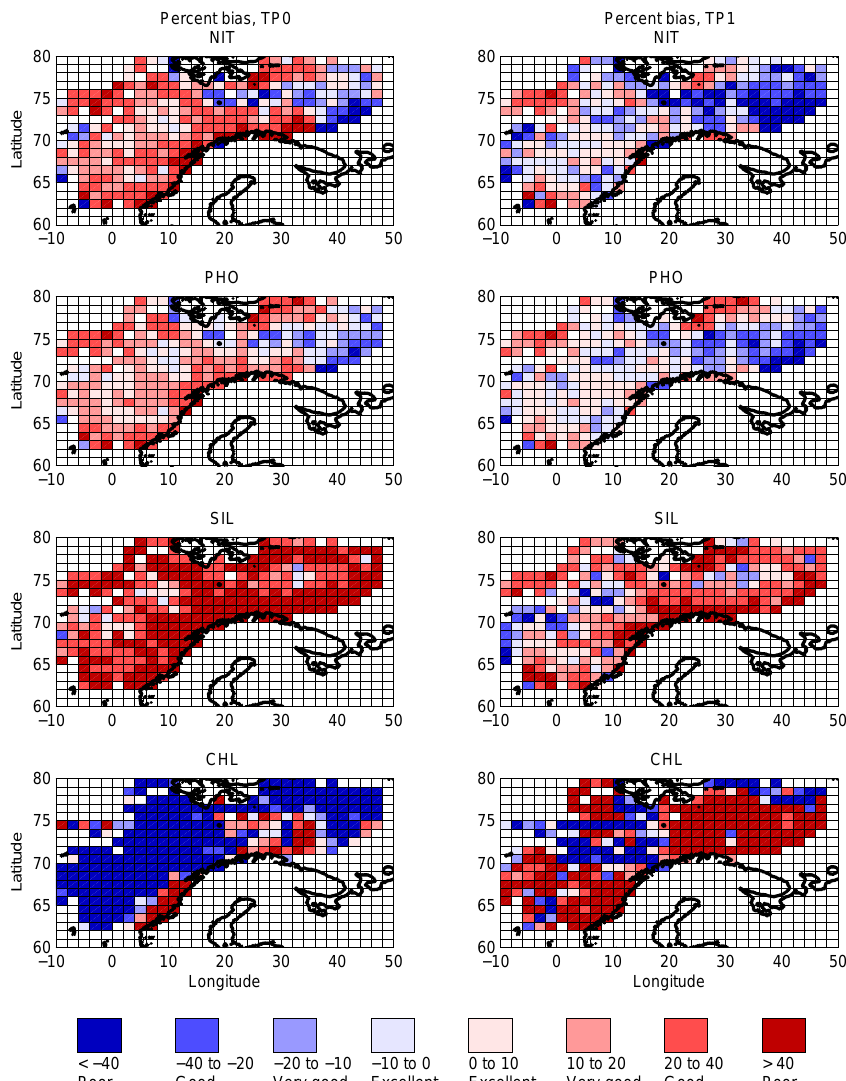
Figure 8. Pbias in the upper 100m for the model simulations compared to all available observations from the period 1998–2001 in 2 ◦ × 1 ◦ boxes from the simulations with the fine-scale model with the original (TP0) and final set of parameters (TP1).